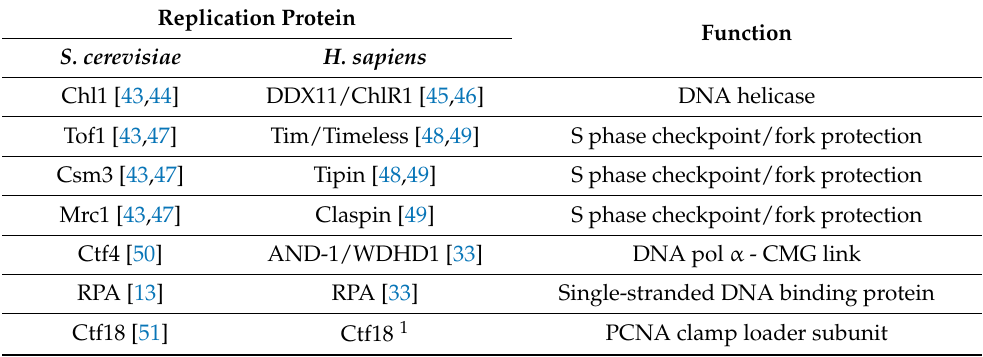
Table 1. DNA replication factors involved in chromosomal cohesion